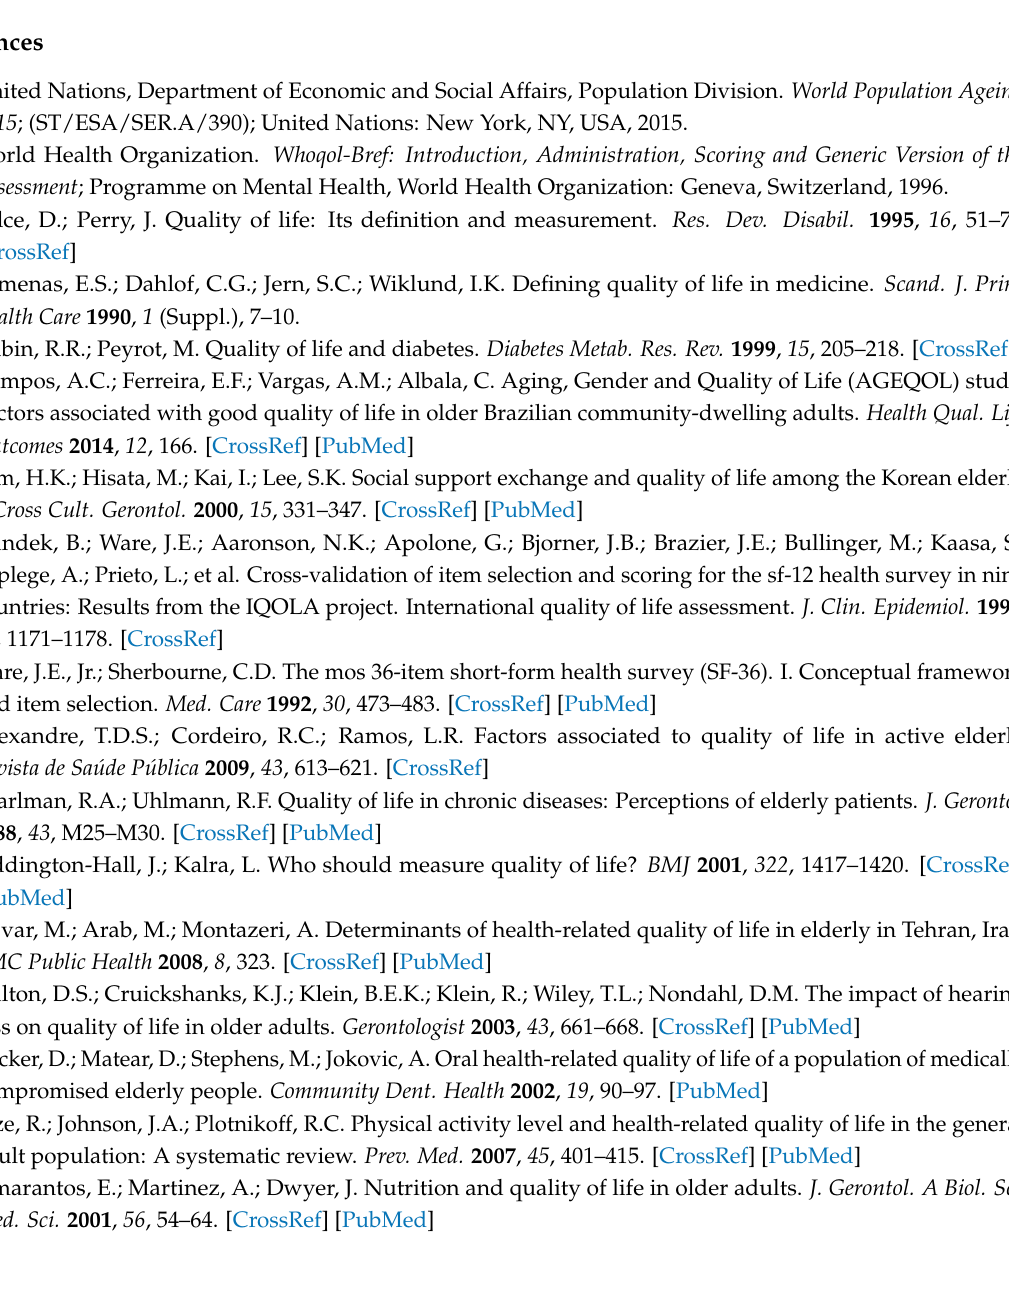
Table S1: Search Strategy, Table S2: Quality of